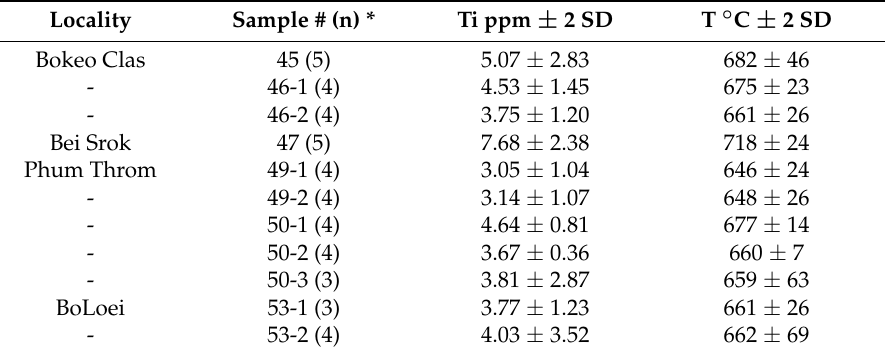
Table 3. Ti-in-zircon temperatures for RVP zircon xenocrysts. Locality Sample # (n) * Ti ppm ± 2